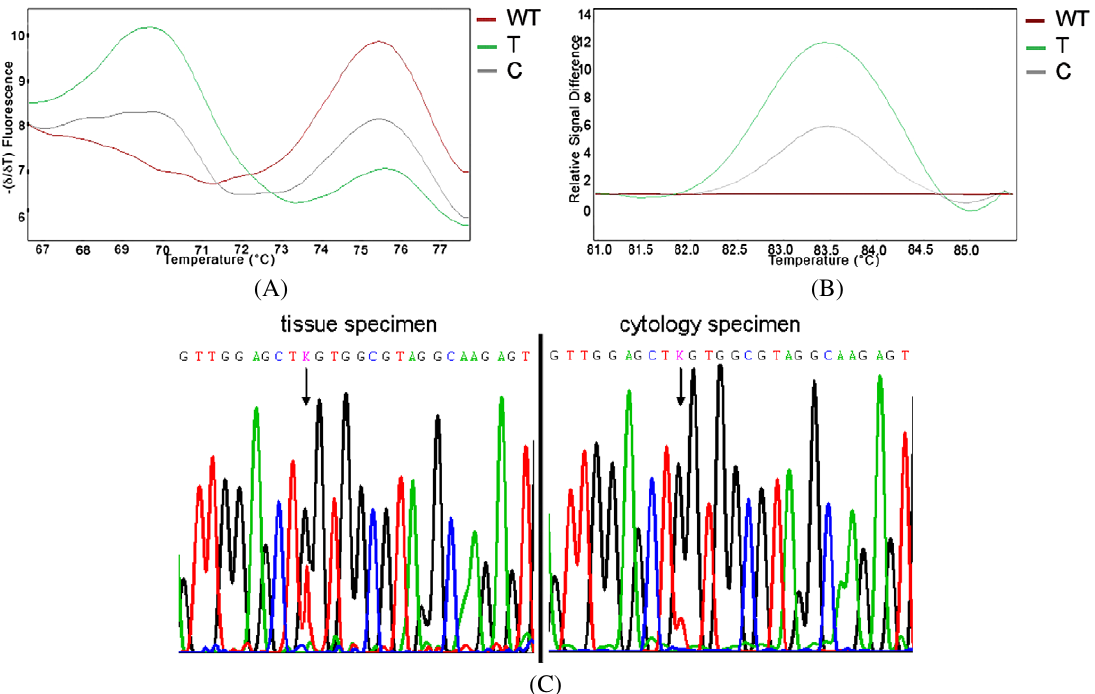
Fig. 2. Suitibility of HRM K-ras exon 1 assay for mutational analysis of cytology specimens containing low tumour cell percentage. The HRM assay was performed using DNA isolated from a BAL specimen (indicated as C or ‘cytology specimen’) of a patient who presented with G12C (34G > T) K-ras exon 1 mutation in its tumour tissue (indicated as T or ‘tissue specimen’). Shown are: (A) the first (probe) melting range of the HRM assay, (B) the normalised and temperature shifted melting plot of the second (amplimer) melting range of the HRM assay, and (C) the sequence confirmation data. WT indicates wild type reference DNA; T indicates tissue specimen; C indicates cytology specimen (i.e. BAL). Note : Colours available in the web version only. K-ras genotype in relation to tumour type and histology K-ras